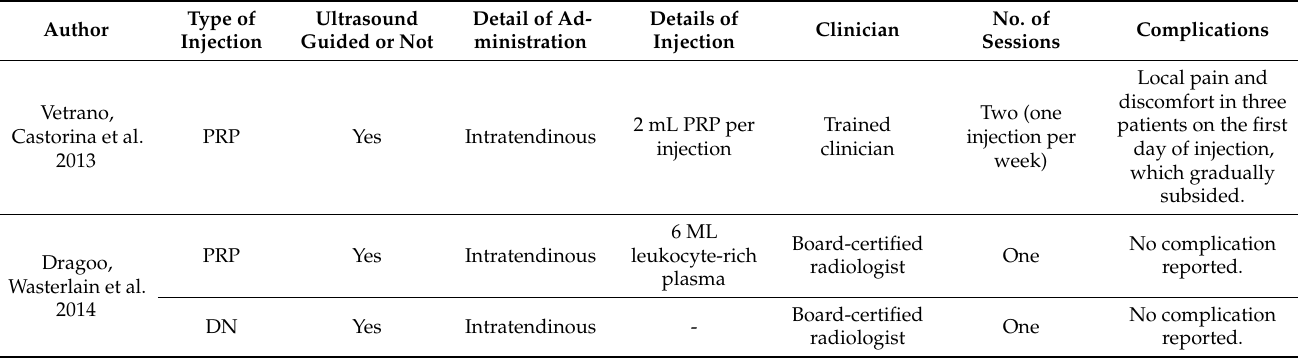
Table 3. Details of the injection